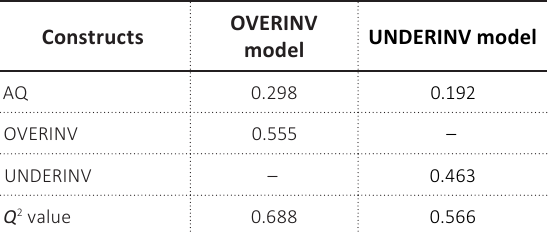
Table 3. R-squares value